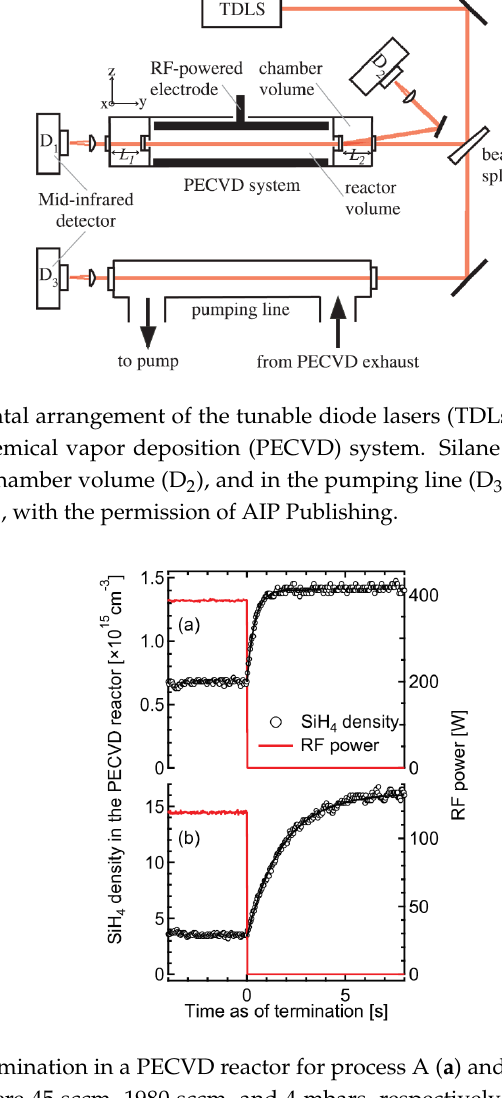
Figure 27. Outline of the Oxford Plasmalab System 100 ICP etch chamber equipped with Q-MACS Process fiber system. CF 2 radicals were detected using a multipass cell just above the wafer [59], Reproduced from [59], with the permission of AIP Publishing.